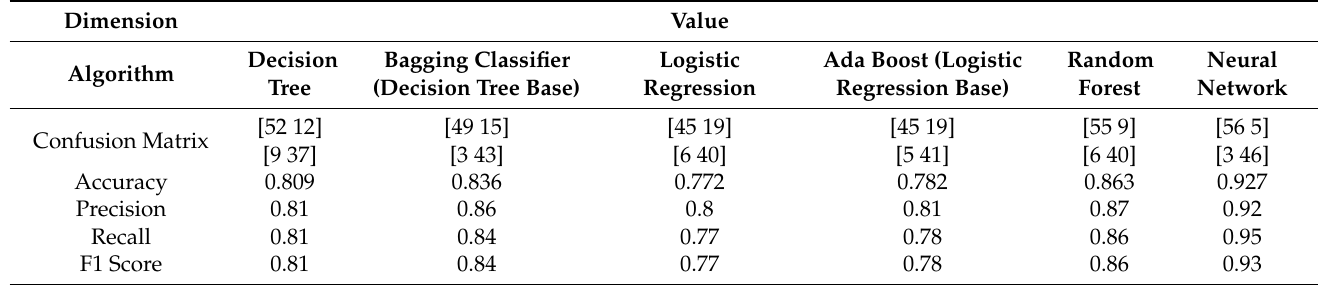
Table 1. Performance measurement